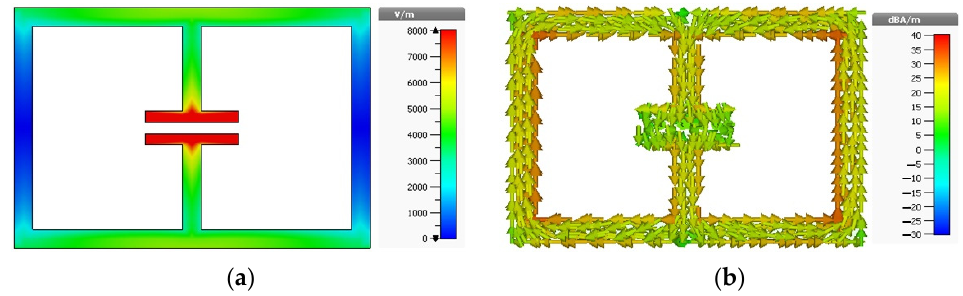
Figure 3. Distribution of ( a ) electric field and ( b ) surface current at 2.67 GHz for Setup 1.